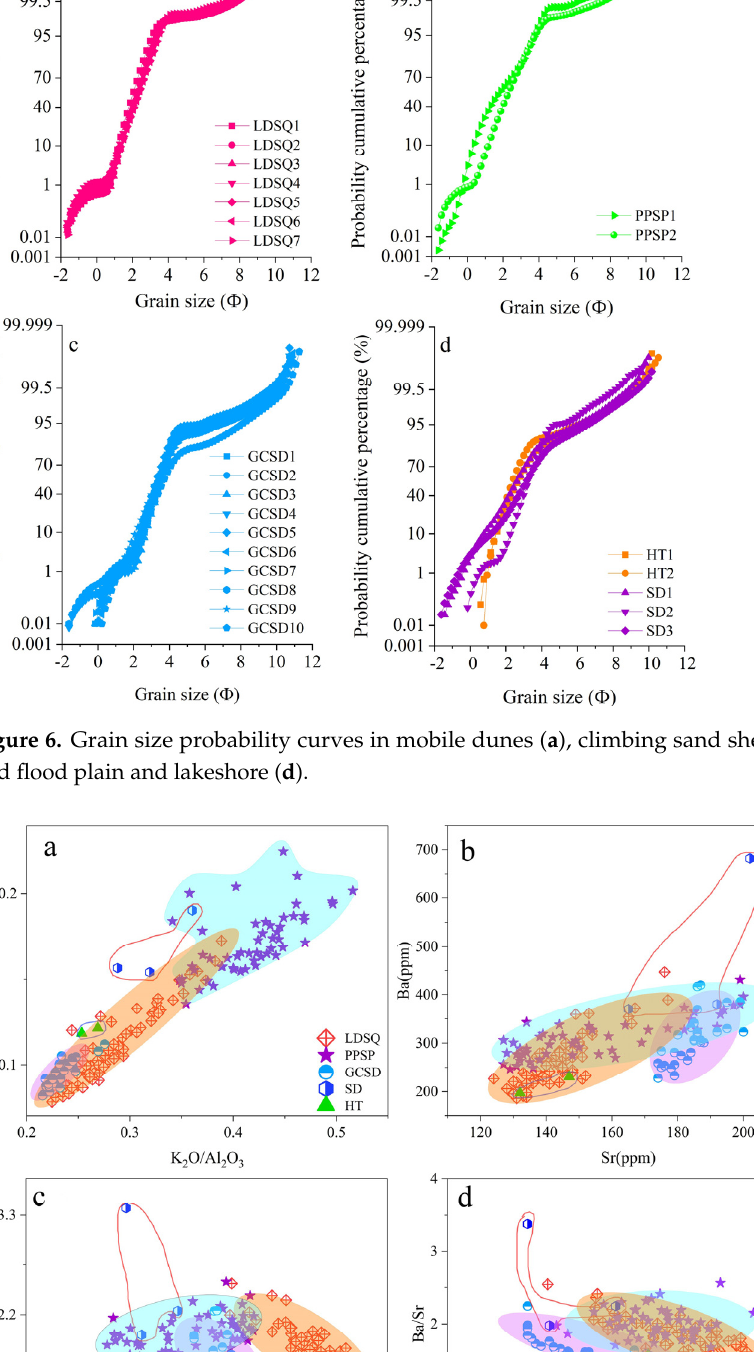
Figure 8. Scatter diagrams of multidimensional scaling analysis ( a ) and principal component anal- ysis ( b ) for mobile dune, nebkha, and flood plain sediments in the Dinggye area. 5. Conclusions A detailed analysis of grain size and major and trace elements of different sand types in the Dinggye area has led to the following conclusions. (1) The major elements are mainly SiO 2 , Al 2 O 3 , and CaO; SiO 2 is essentially the same as UCC, and CaO is enriched; the trace elements are mainly Ba, Sr, Zr, and Rb; V, Co, As, and Pb are enriched. Mobile dunes, climbing sand sheets, and nebkhas have dif- ferences in chemical element composition and are UCC-normalized. MgO, TiO 2 , Ni, Pb, and Nb are present in high concentrations in mobile dunes, with higher concen- trations of SiO 2 , CaO, K 2 O, Na 2 O, P 2 O 5 , V, Cr, Co, Cu, Ba, and Ce in climbing sand sheets; and higher Al 2 O 3 , Fe 2 O 3 , La, Zn, As, Sr, Y, Zr, Rb, and Ga in nebkhas.